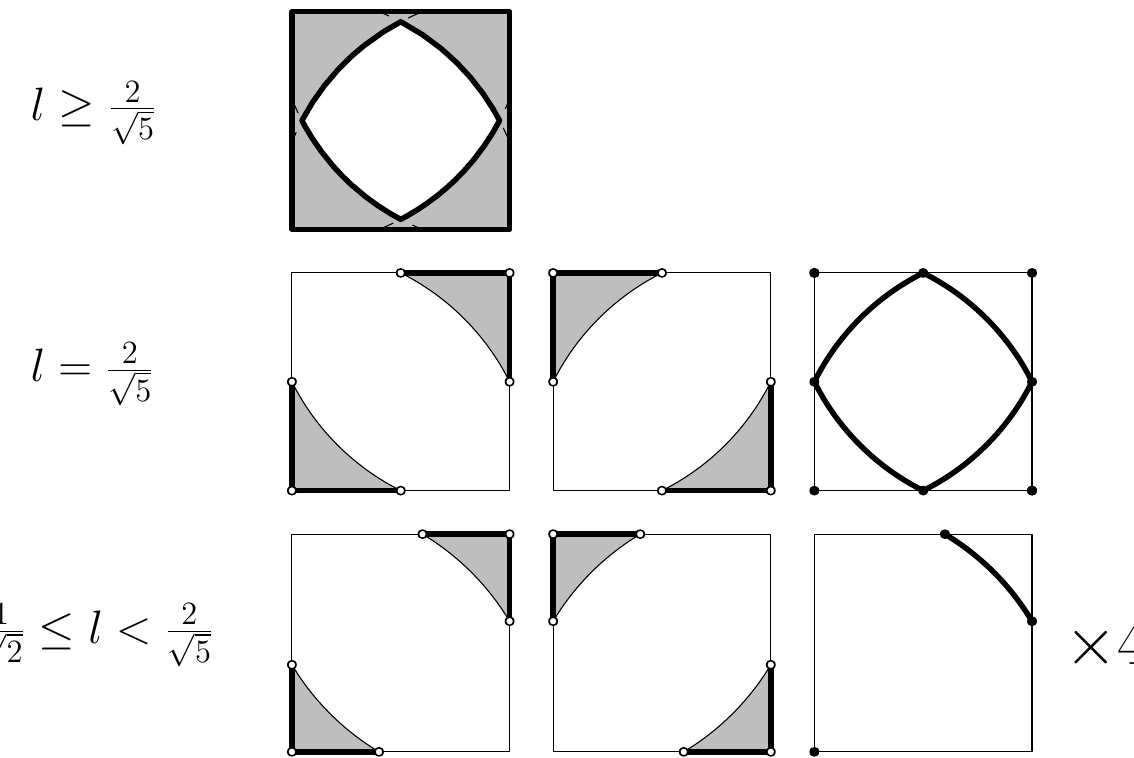
Figure 3: The non-trivial connected components of G 1 [ C 2 ( l )] for varying l . In each square, R 2 the component consists of the shaded area, the thick black lines, and the filled nodes. Each of the remaining points in the middle of the square, which are in none of the displayed components, is a connected component of its